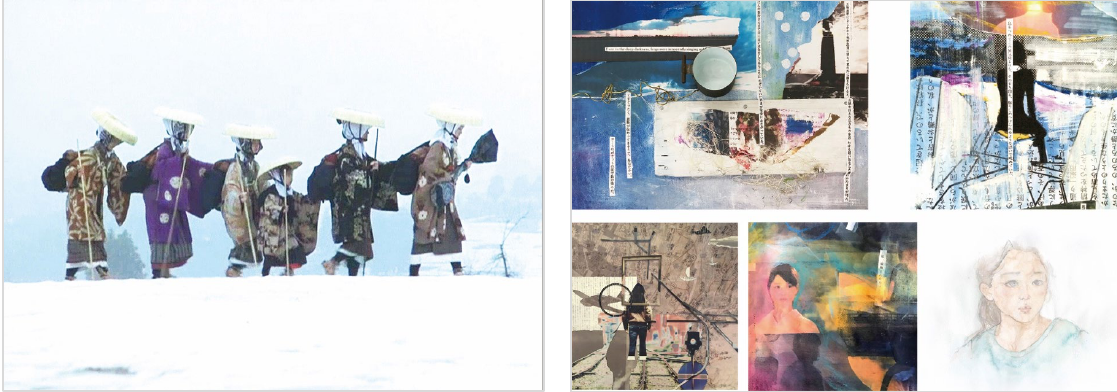
Figure 29 Expressions from the Hokuriku region workshop “For the Sake of Anyone Whom We Might Not Have Seen Yet” since